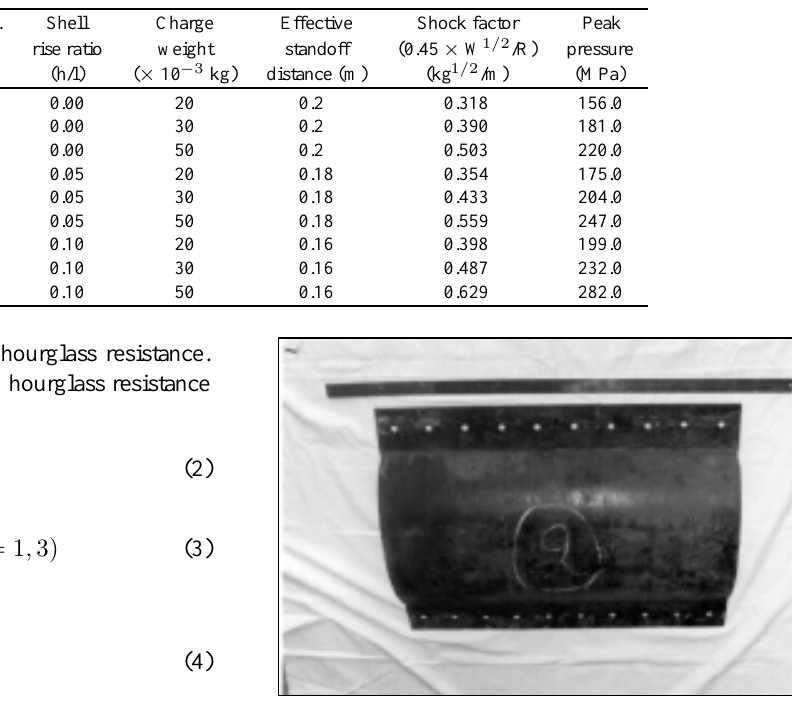
Fig. 2. Typical test panel ( h/l = 0 . 1